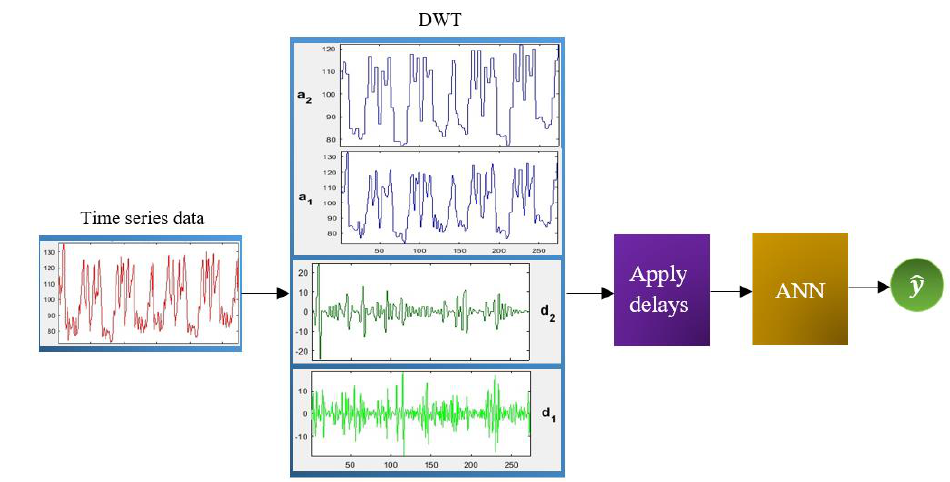
Fig. 4. General structure of the employed DWTNN